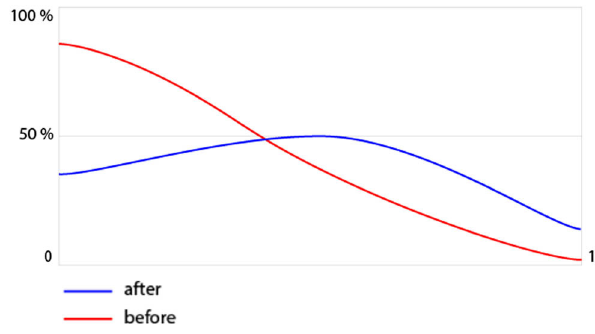
Figure 12: Graph showing the di ff erence in the arousal level of all subjects before and after the experience.